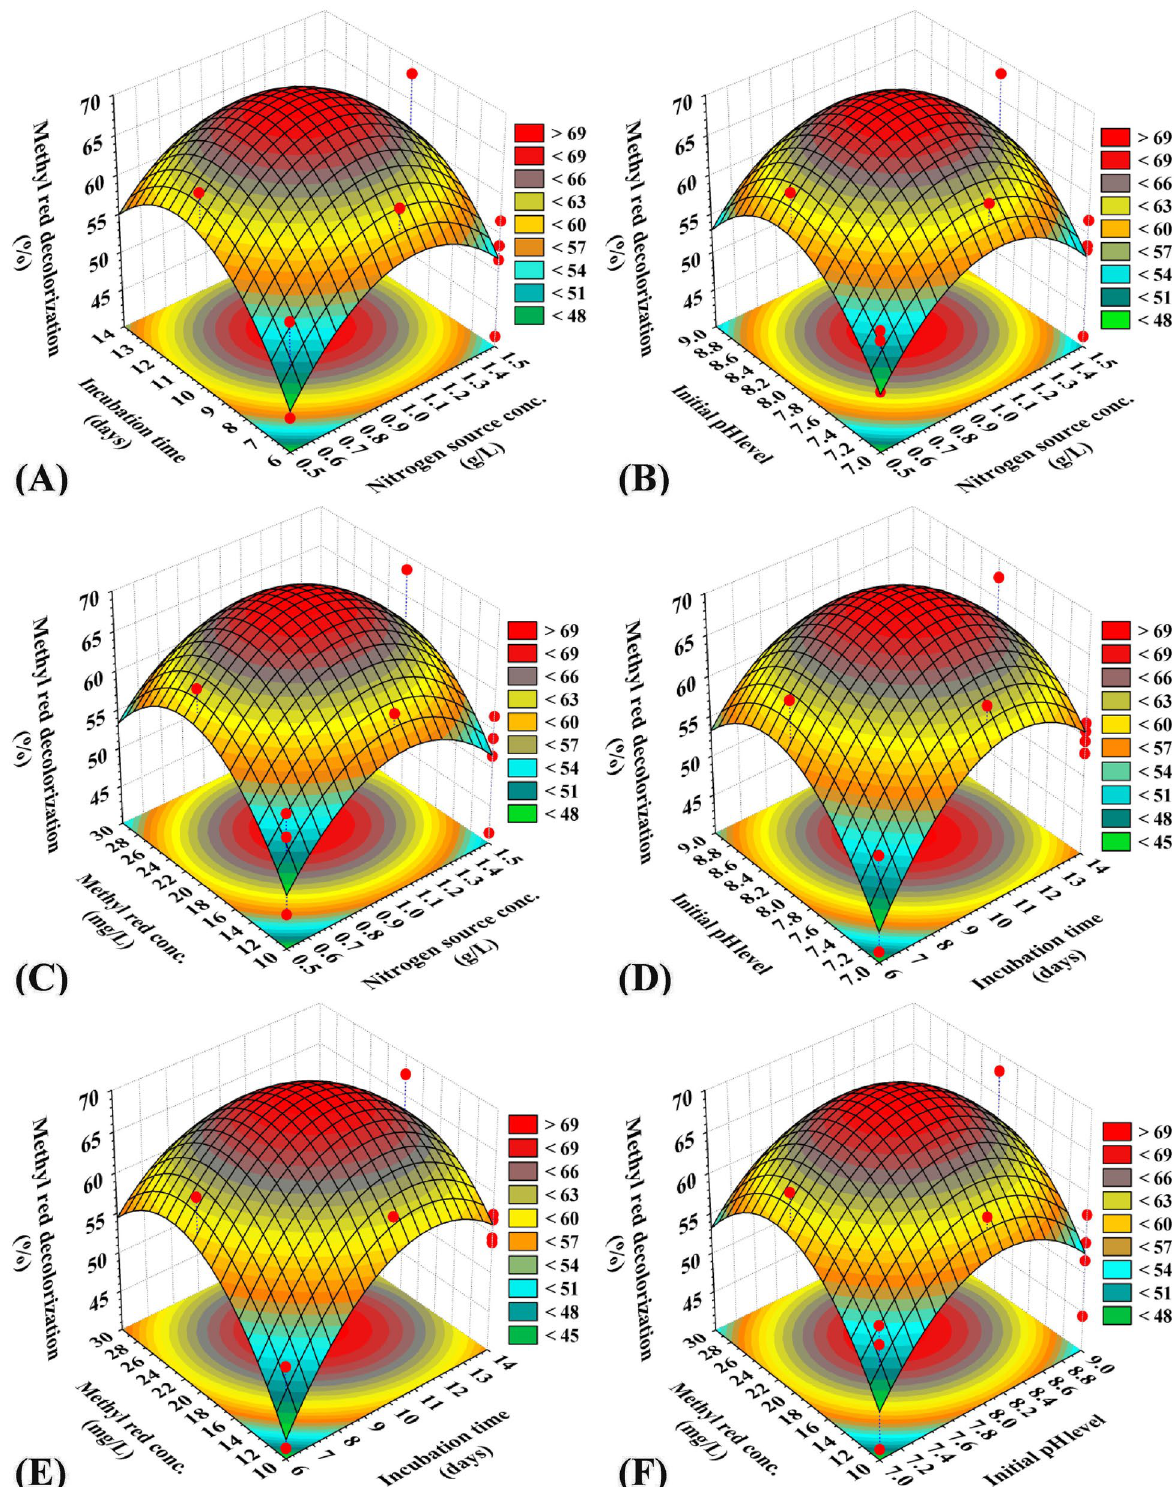
Figure 4. Three-dimensional surface plot for methyl red decolorization (%) by using Scenedesmus obliquus , showing the interactive effects of the tested